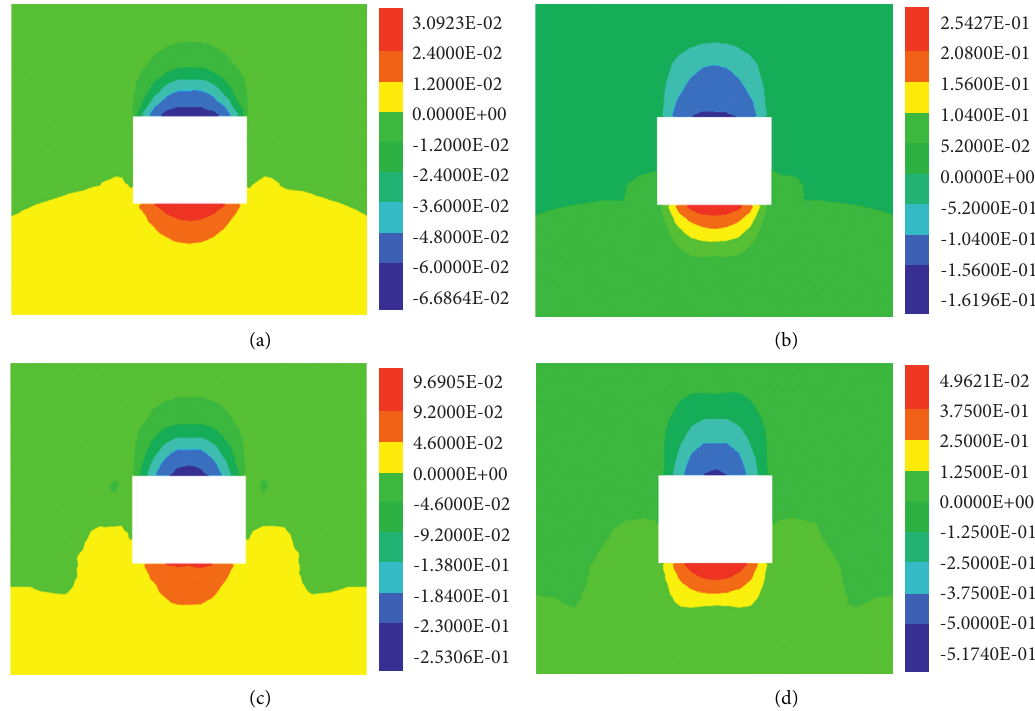
Figure 7: Vertical displacement distributions of surrounding rock of weakly cemented soft rock in the roadway under different simulation schemes. (a) Without softening and expansion. (b) With expansion. (c) With softening. (d) With softening and